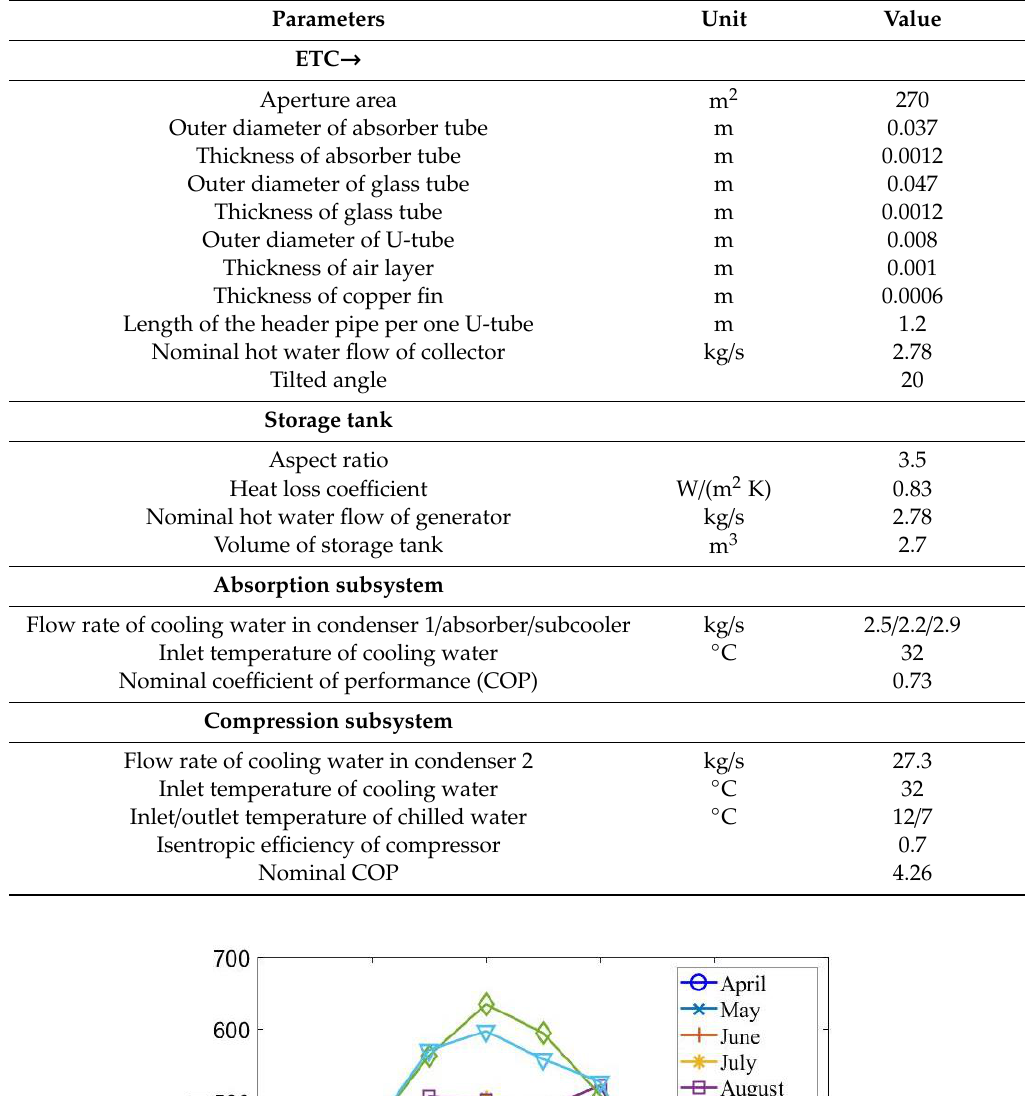
Table 3. Operation parameters of SASCHCS.